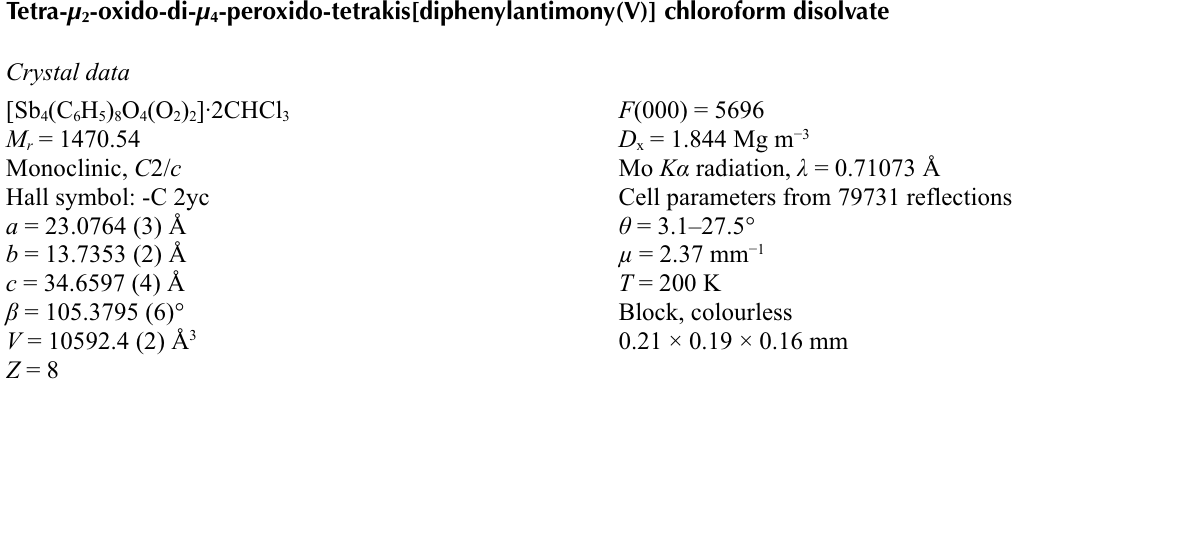
The packing of the title compound, viewed along [0 1 0]. Tetra- µ -oxido-di- µ -peroxido-tetrakis[diphenylantimony(V)] chloroform 2 4